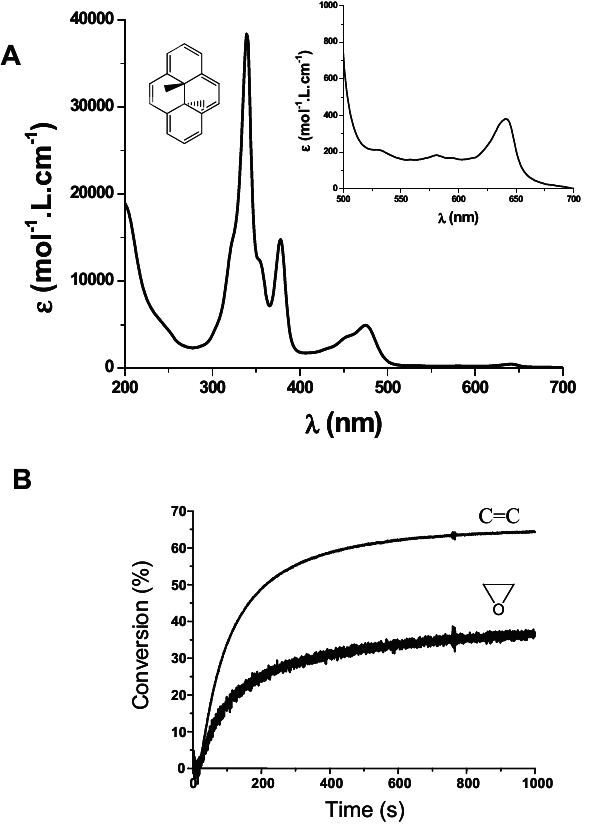
Figure 1. ( A ) UV-visible ground state spectrum of DHP in acetonitrile. ( B ) Photopolymerization profiles of a TMPTA/EPOX blend (50%/50%) under air using the DHP/DPI/NVK system (1%/2%/3% w / w / w ) upon a laser diode exposure at 635 nm (the conversions for double bond (for TMPTA) and epoxy (for EPOX) were followed by FTIR spectroscopy as presented in